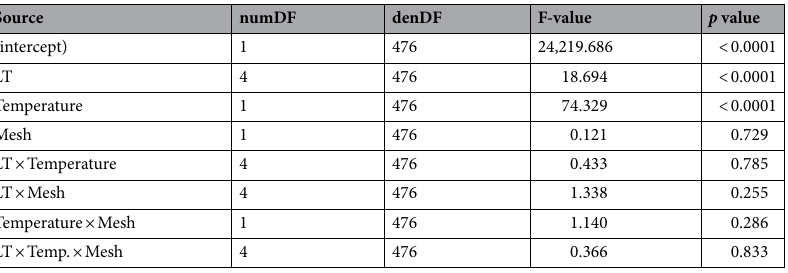
Table 1. Results of linear mixed effect models examining how decomposition rates changed in response to litter treatments (LT), temperature, mesh size (fine versus coarse) and interactions. Marginal R 2 = 0.24, conditional R 2 = 0.25. Significance at p < 0.05. numDF = numerator degrees of freedom, denDF = denominator degrees of freedom.